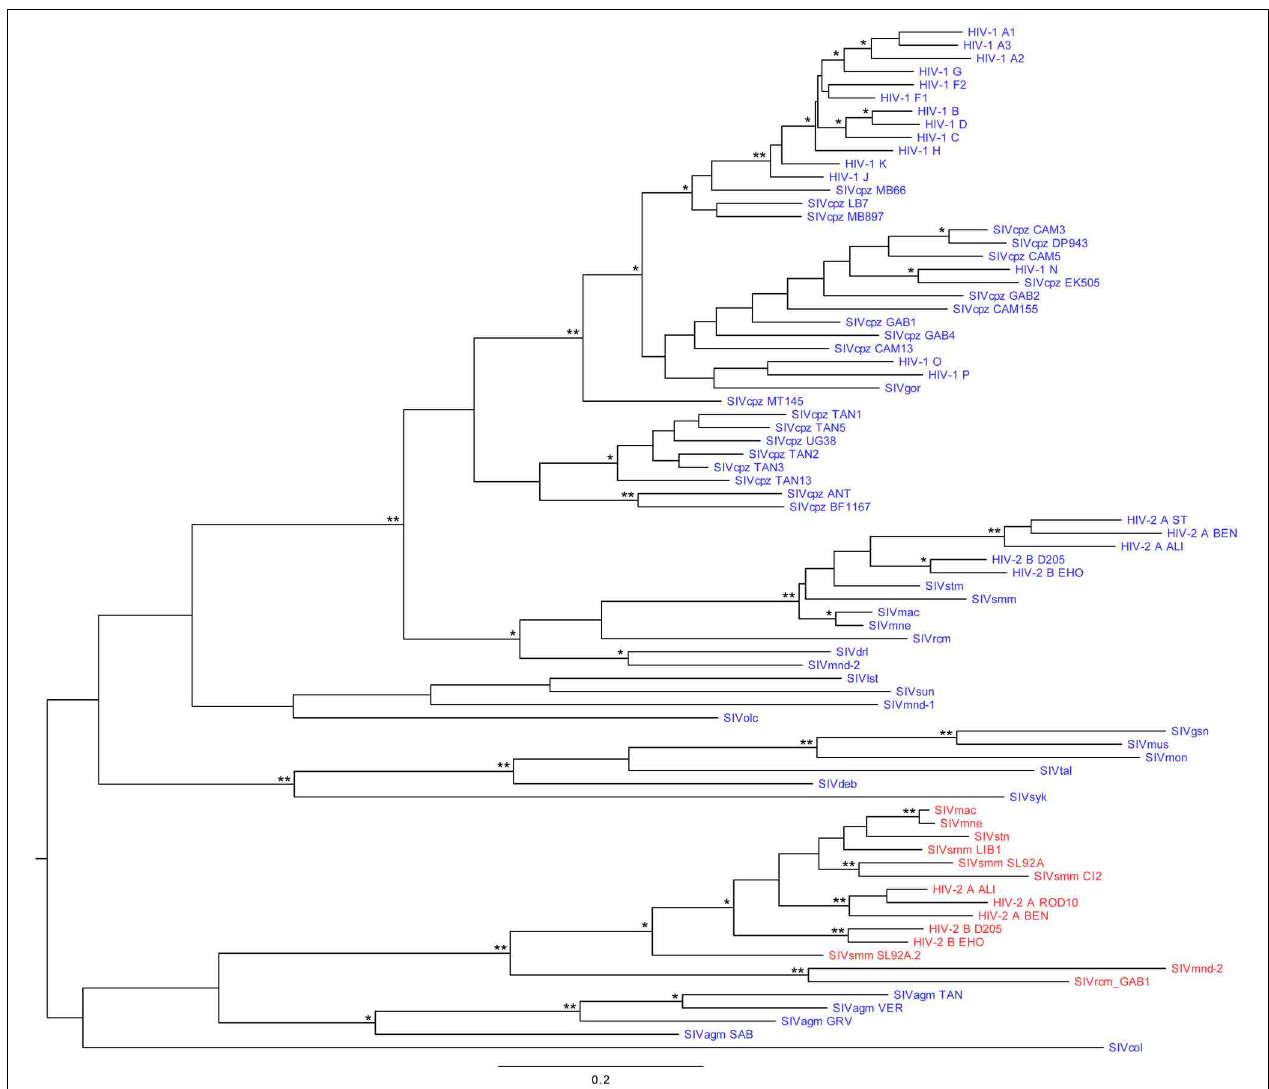
FIGURE 5 | Maximum likelihood phylogeny of primate lentiviruses vpr and vpx genes. vpr are represented in blue and vpx in red. Branch lengths represent nucleotide substitutions per site, as indicated in the scale. Branch supports are indicated by one asterisk ( ≥ 90% confidence) or two asterisks ( ≥ 99%). The tree was rooted using the midpoint rooting method. Abbreviations: HIV, human immunodeficiency virus; SIV, simian immunodeficiency virus; cpz, chimpanzee ( Pan troglodytes ); gor, gorilla ( Gorilla gorilla ); stm, stump-tailed macaque ( Macaca arctoides ); smm, sooty mangabey monkey ( Cercocebus atys ); mac, rhesus macaque ( Macaca mulatta ); mne, pig-tailed macaque ( Macaca nemestrina ); rcm, red-capped mangabey ( Cercocebus torquatus ); drl, drill monkey ( Mandrillus leucophaeus );